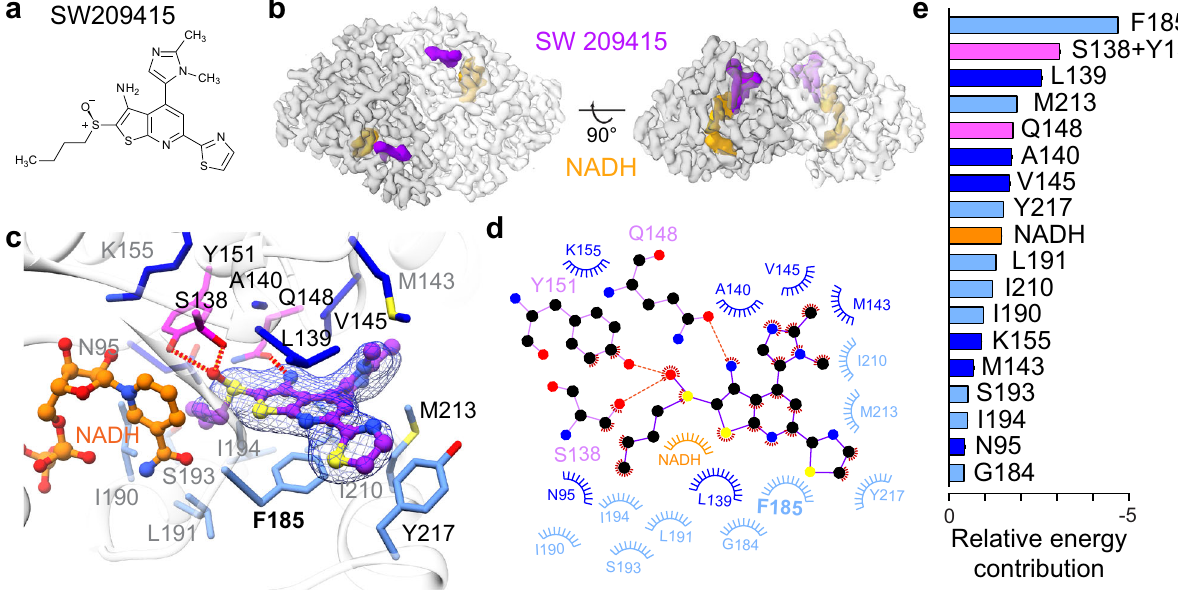
Fig. 1 | Cryo-EM structure of human 15-PGDH in complex with NADH and (+)-SW209415. a The chemical structureof (+)-SW209415. b The cryo-EMelectron density mapof the 15-PGDH-NADH-SW209415complex, with each protomer inthe homodimeric assembly differentially colored. (+)-SW209415 and NADH are shown in purple and orange, respectively. c Zoom-in view of the drug binding pocket surrounding(+)-SW209415(purple).Residuesformingthedrug-bindingpocketare color-codedinthreegroupsthoseinthecatalyticcore(magenta),thosearoundthe